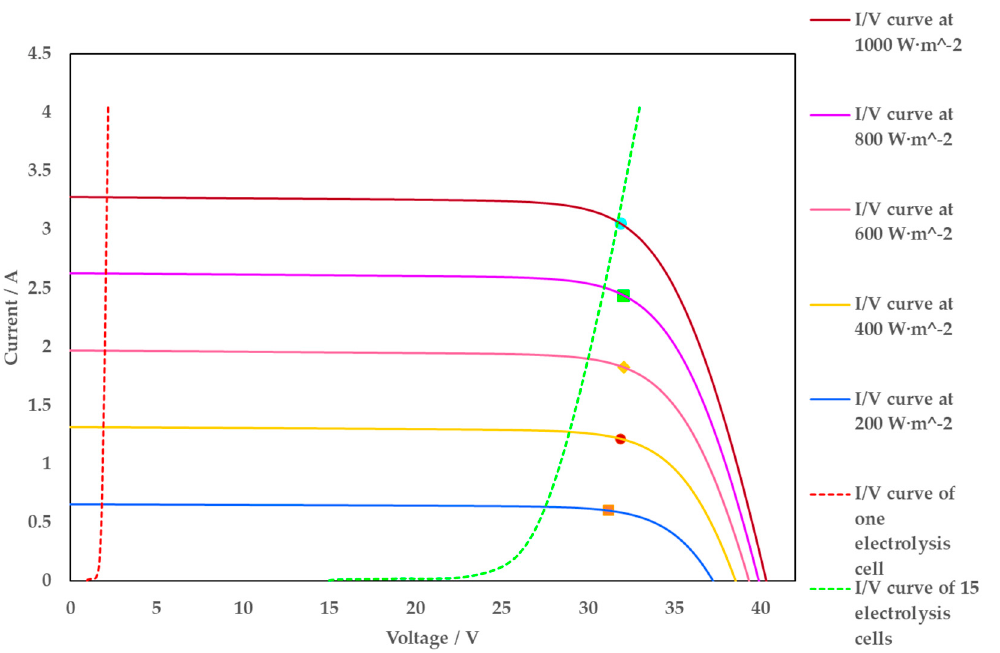
Figure 6. Coupling Solartec SST72 110 24 106W PV module − 5 cm 2 electrolyzer.